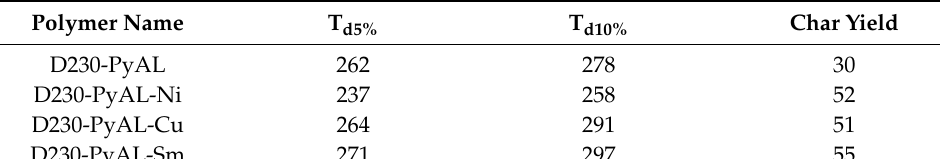
Table 4. TGA results for polymers and coordination polymers.